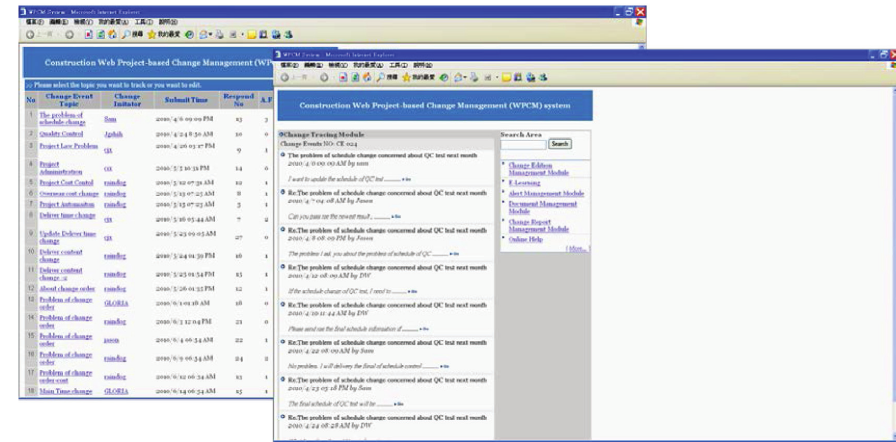
Fig. 5. Screenshot taken from the WPCM system in the case